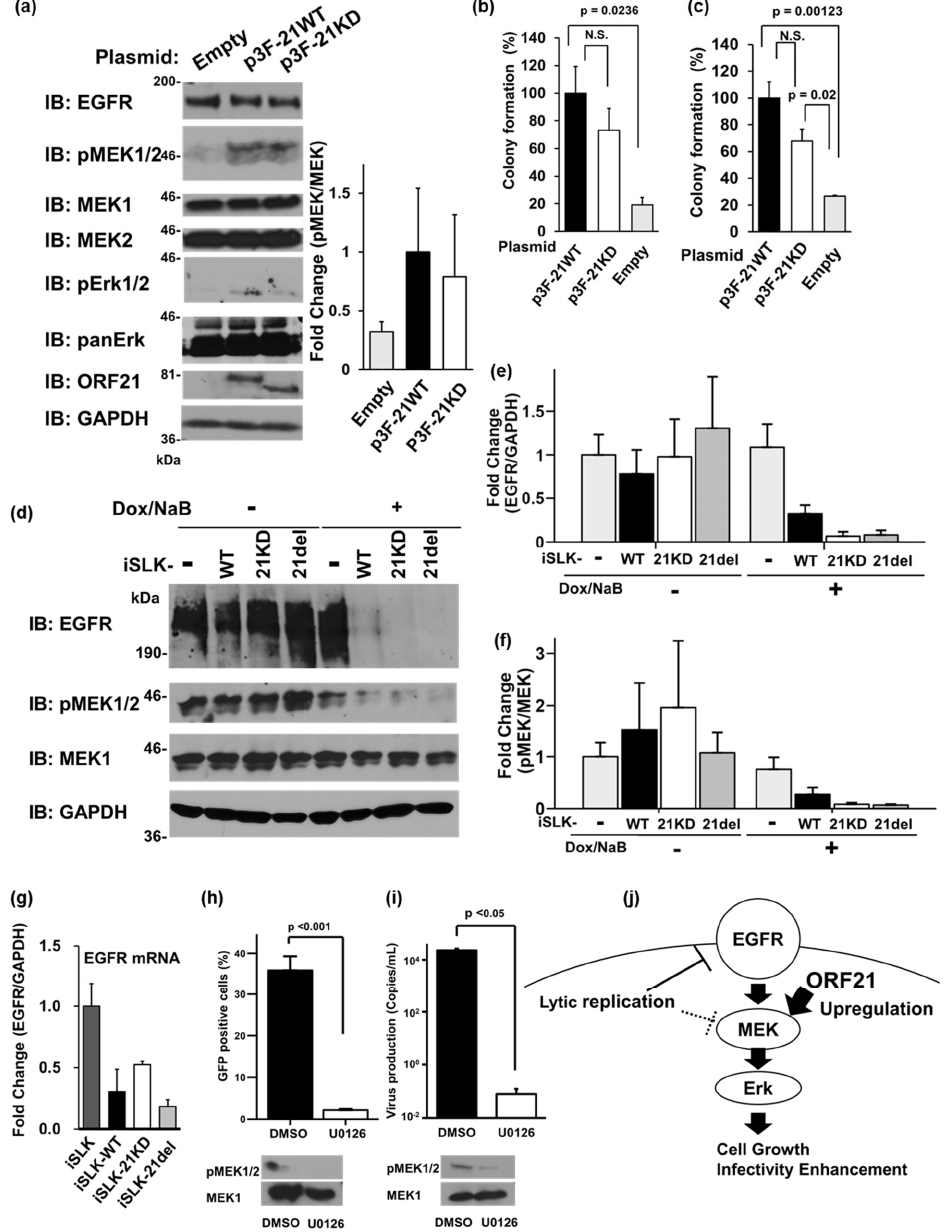
Figure 7. ORF21 upregulated the MEK phosphorylation and anchorage-independent cell growth. ( a – c ) Upregulation of MEK phosphorylation, anchorage-dependent proliferation, and anchorage- independent proliferation by ORF21. HeLa cells were transfected with empty, 3×Flag-ORF21 wildtype (p3F-21WT), or 3×Flag-ORF21-kinase dead (p3F-21KD) plasmid and cultured for 48 h, fol- lowed by ( a ) Western blotting, ( b ) cell proliferation assay, or ( c ) soft agar colony formation assay.